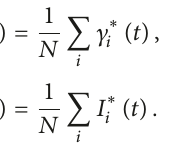
scheme with step size 0.01. Here we have to point out that some parameter values are chosen hypothetically due to the unavailability of real world